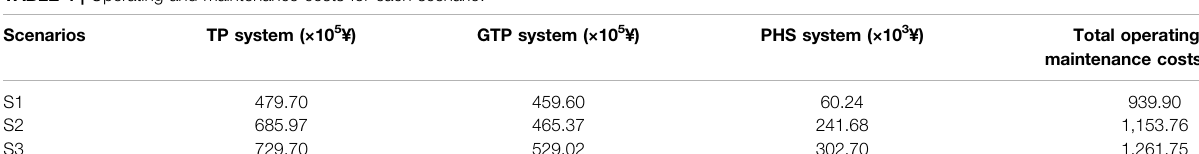
TABLE 4 | Operating and maintenance costs for each scenario.